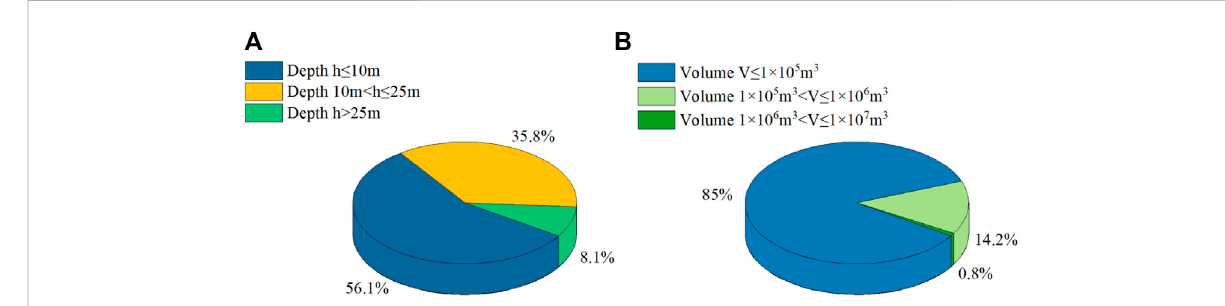
FIGURE 3 (A) Percentage of landslides with different depths; (B) Percentage of landslides with different volumes.